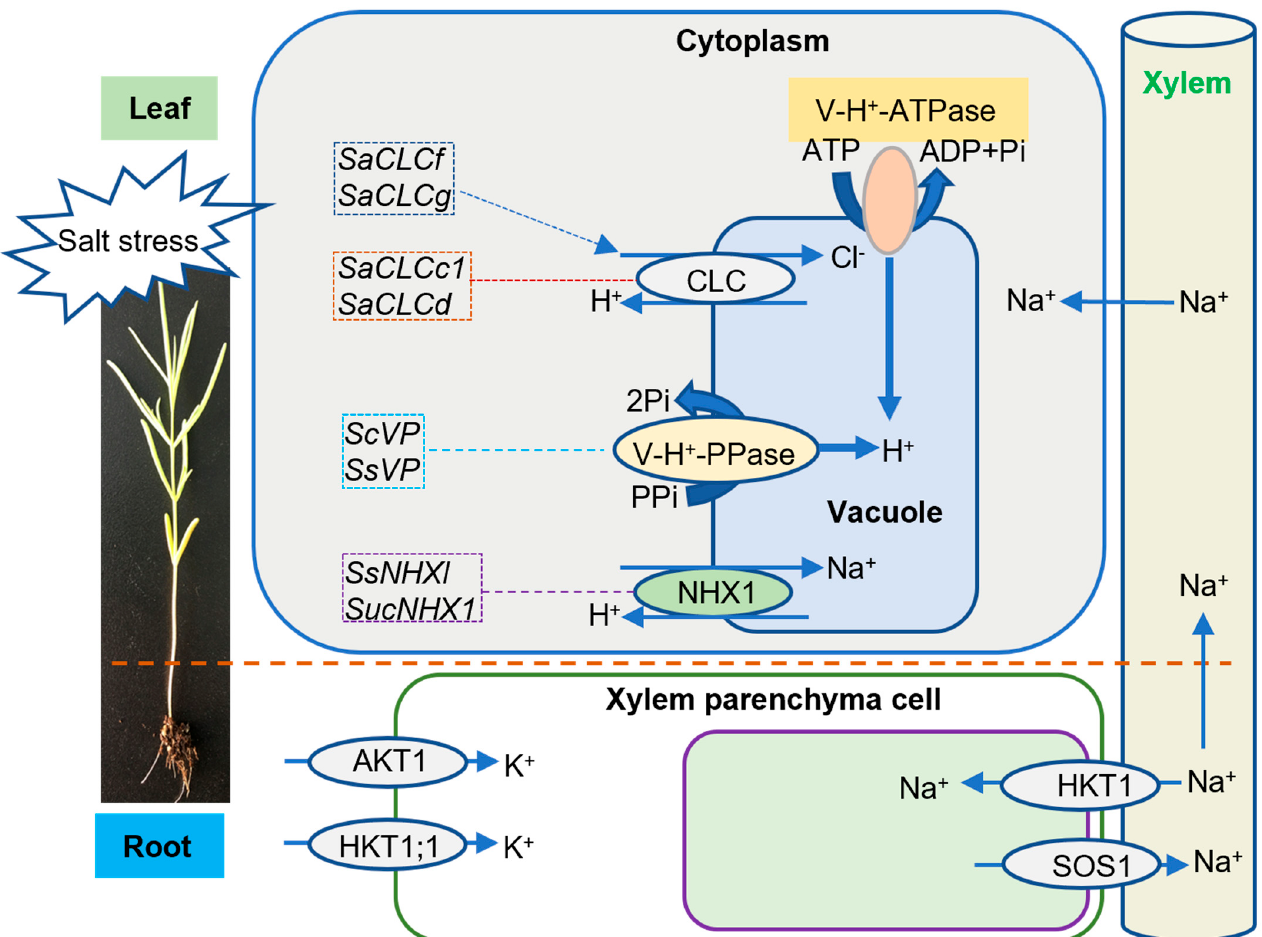
Figure 1. Schematic diagram of transmembrane transporters transporting Na + , H + , K + , and Cl – in Suaeda .